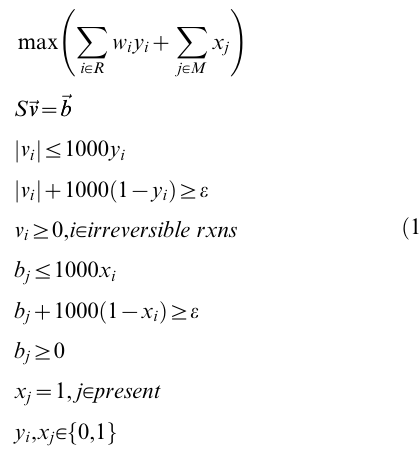
Table S1 Evaluation of the models by comparison to curated tissue-specific enzymes. For each model, the set of genes is compared to the set of genes annotated as existing in the corresponding tissue in BRENDA. The p-values are derived from hypergeometric